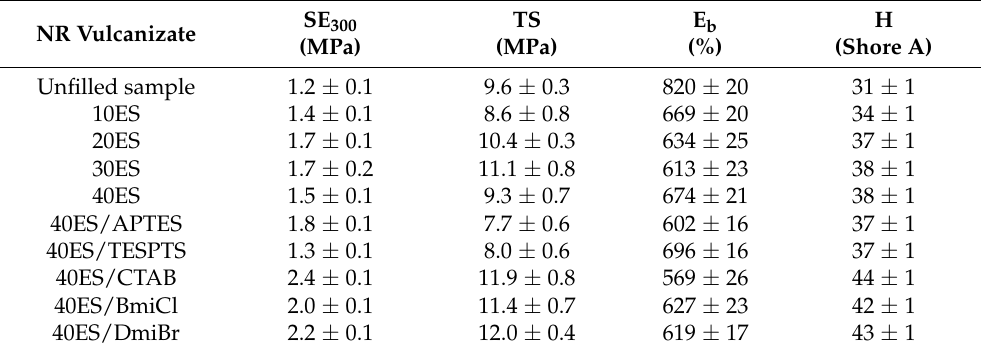
Table 6. Tensile properties and hardness of NR vulcanizates (SE 300 —stress at a relative elongation of 300%; TS—tensile strength; E b —elongation at break; H—hardness). SE 300 NR Vulcanizate